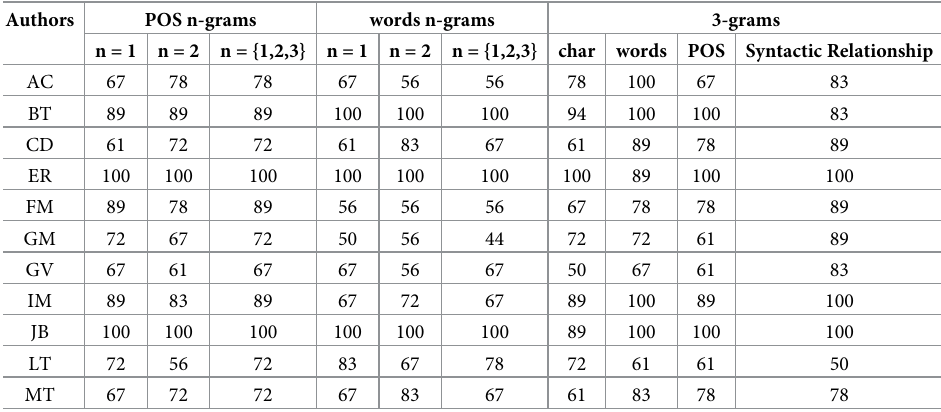
Table 12. Results for different types and sizes of n-grams in complete novels using ALL features.